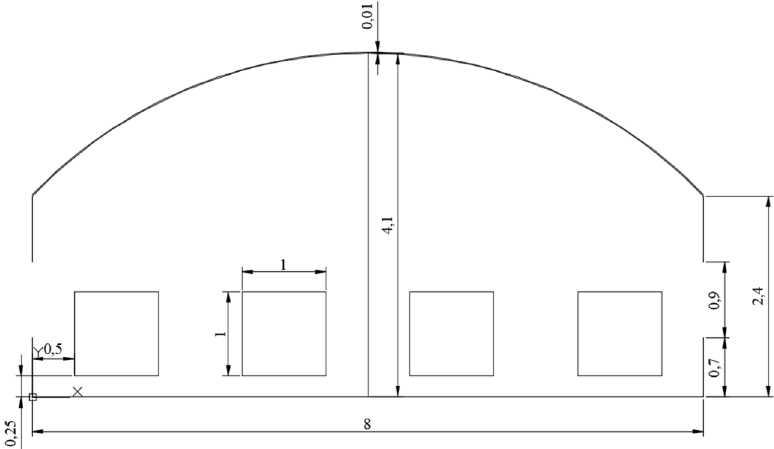
Figure 1. Simulated greenhouse geometry.